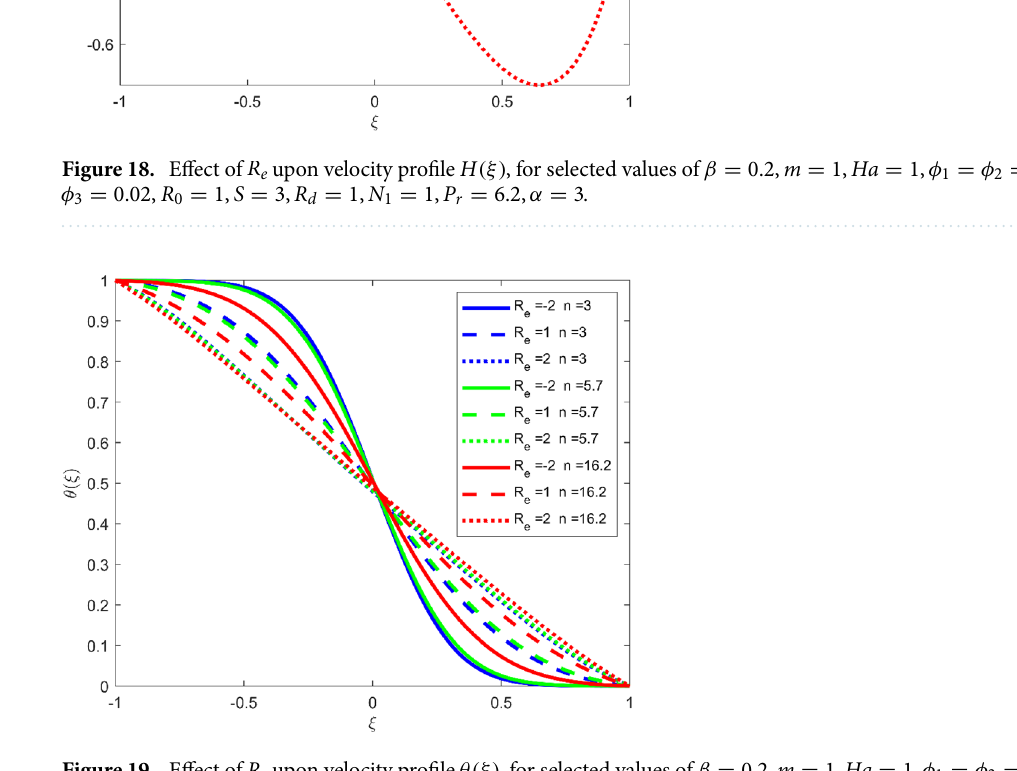
Figure 19. Effect of R e upon velocity profile θ(ξ) , for selected values of β = 0.2, m = 1, Ha = 1, φ 1 = φ 2